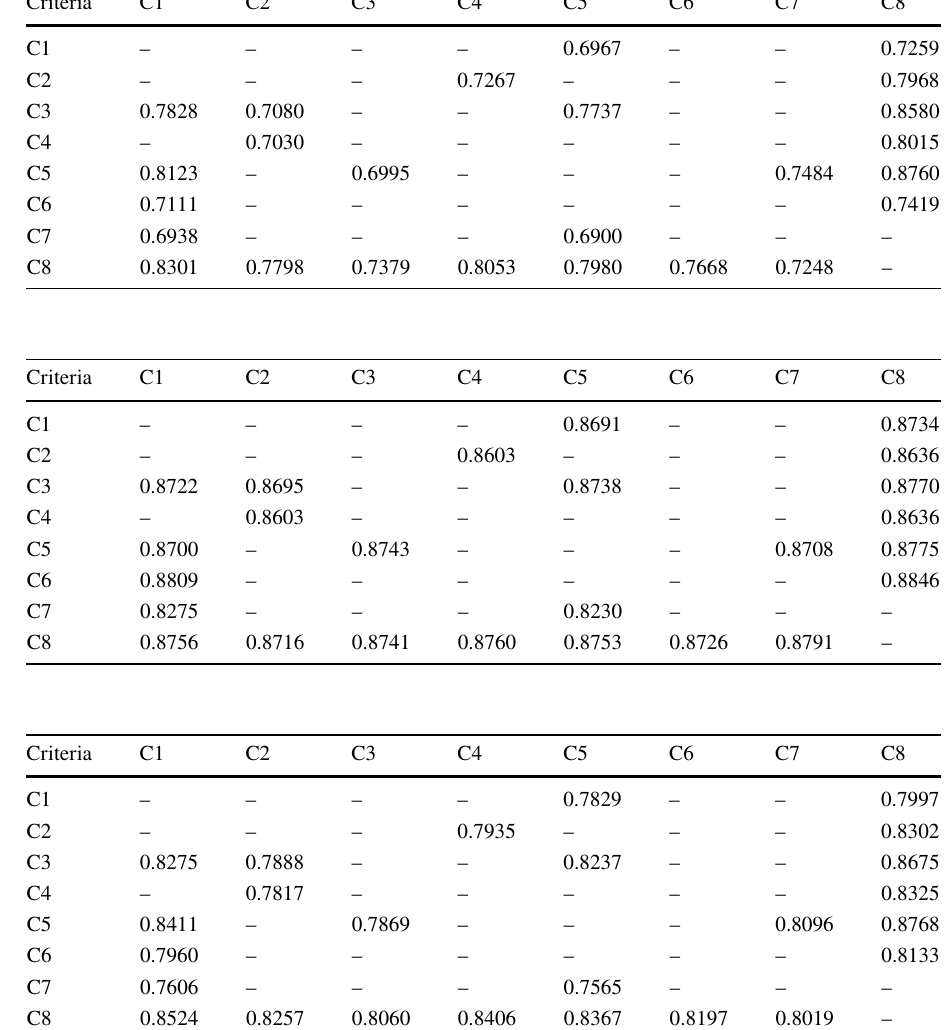
interaction matrix r _ expert